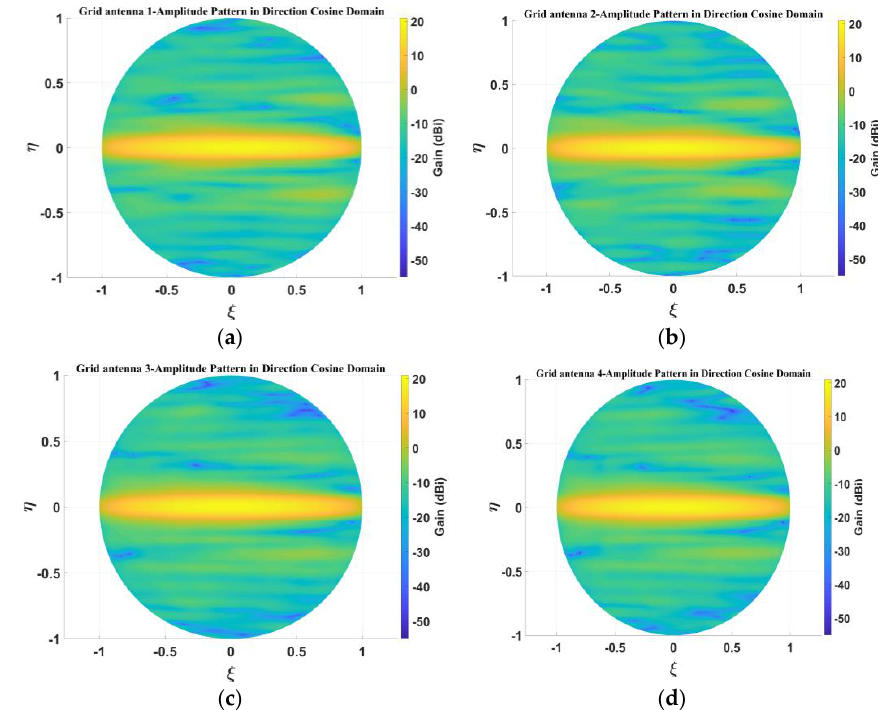
Figure 8. Simulated amplitude pattern in direction cosine domain: ( a ) grid antenna 1; ( b ) grid antenna 2; ( c ) grid antenna 3; ( d ) grid antenna 4.